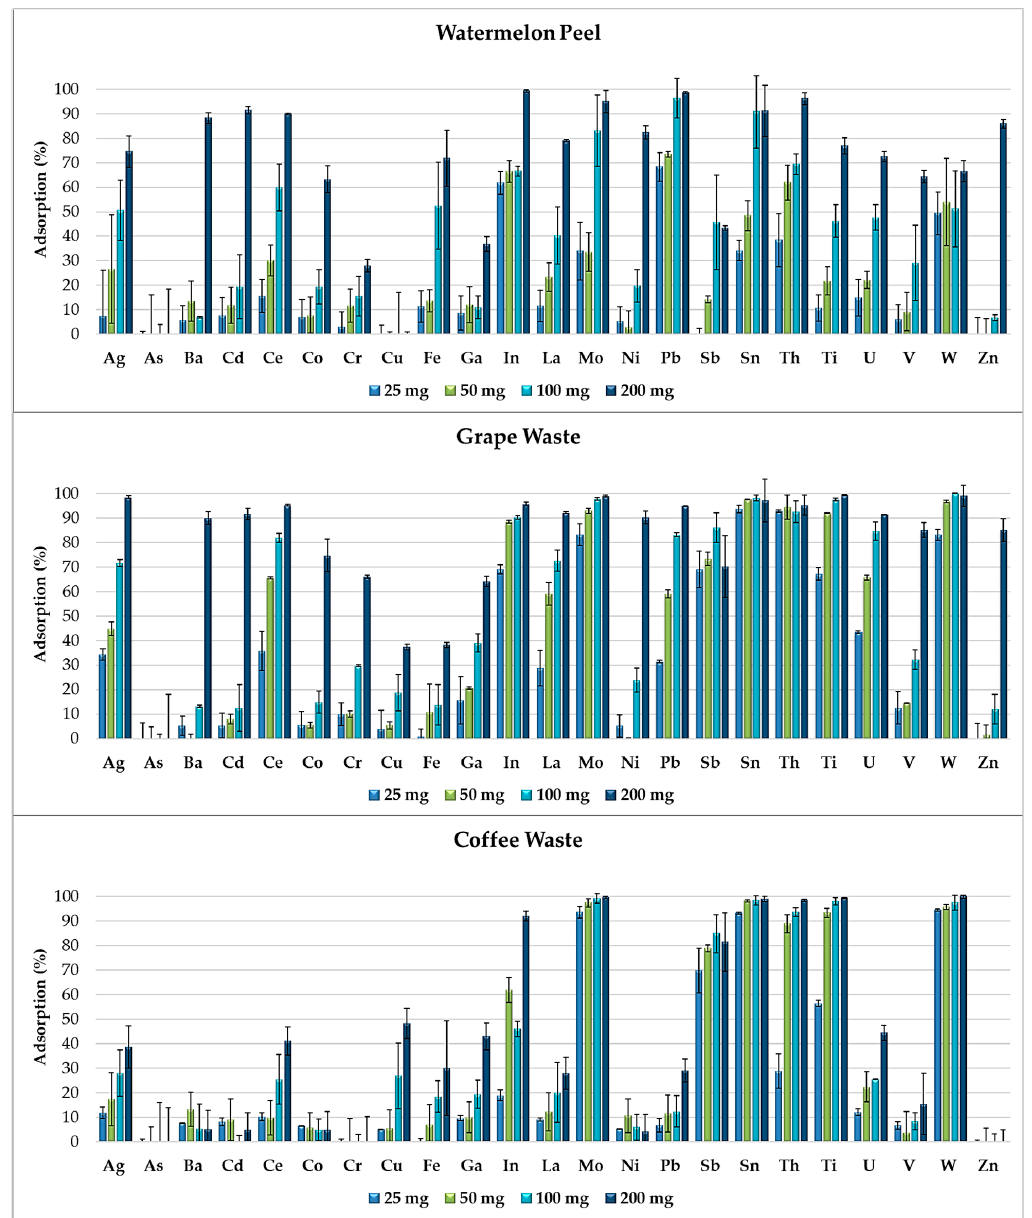
Figure 4 . Removal efficiency of watermelon peel, grape waste and coffee waste, exposed in increasing amounts (25, 50, 100 and 200 mg) to the multi-element solution at pH 2.0.